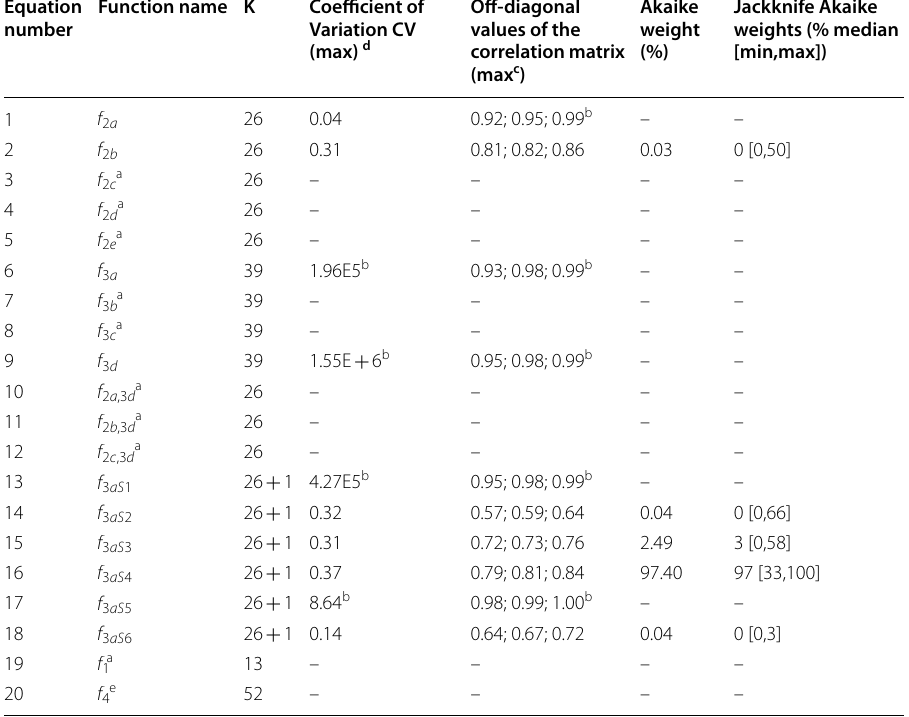
Table 1 Goodness of fits and Akaike weights for the PBMS